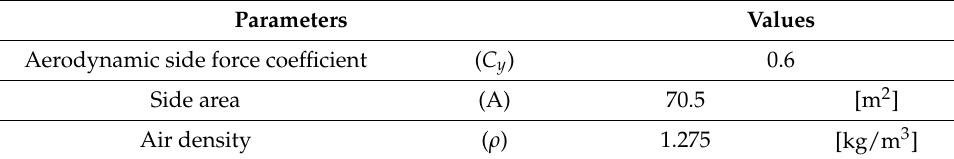
Table 8. The specifications of the high-speed train.